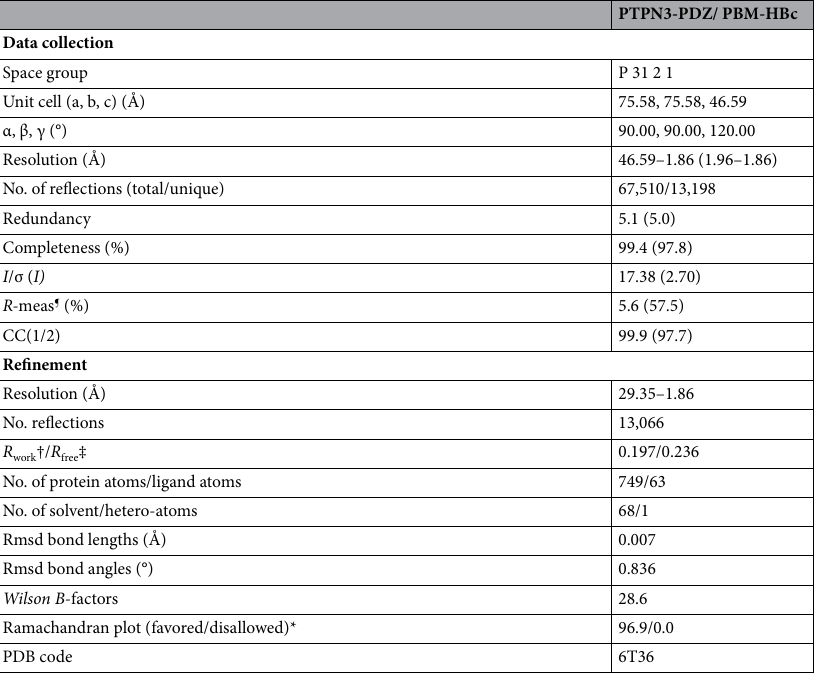
Table 1. Data collection and refinement statistics. Values in parenthesis correspond to the highest resolution shell. ¶ Rmeas = Σh(n/n−1) 1/2 Σi |Ii( h )—<I(h)>|/ΣhΣi Ii( h ), where Ii( h ) and <I( h )> are the ith and the mean measurement, respectively, of the intensity of reflection h. † Rwork = Σh||Fobs(h)|−|Fcalc(h)||/Σh|Fobs(h)|, where Fobs(h) and Fcalc(h) are the observed and calculated structure factors, respectively. No I/σ cut-off was applied. ‡ Rfree is the R-value obtained for a test set of reflections consisting of a randomly selected 5% subset of the data set excluded from refinement. *Categories were defined by